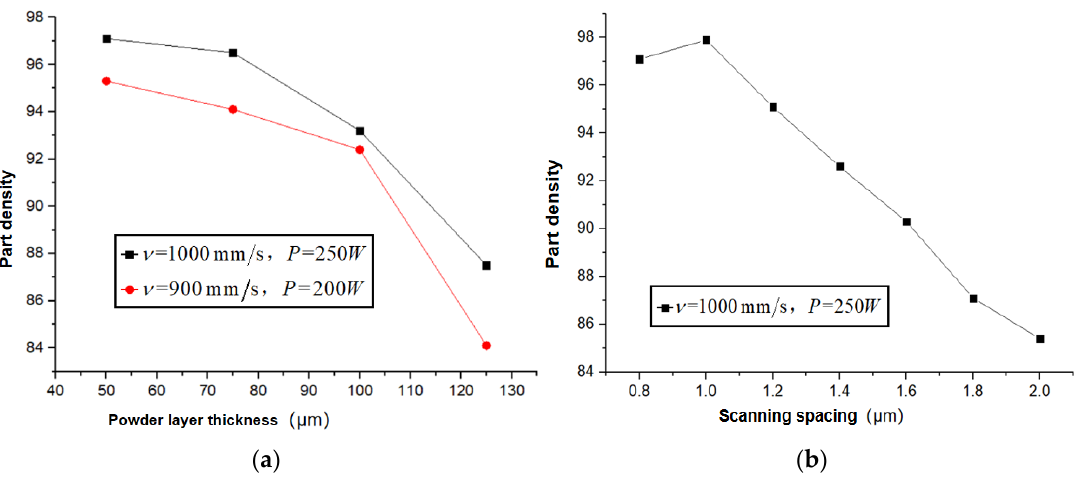
Figure 5. Effect of powder layer thickness ( a ) and scanning spacing ( b ) on SLMed part